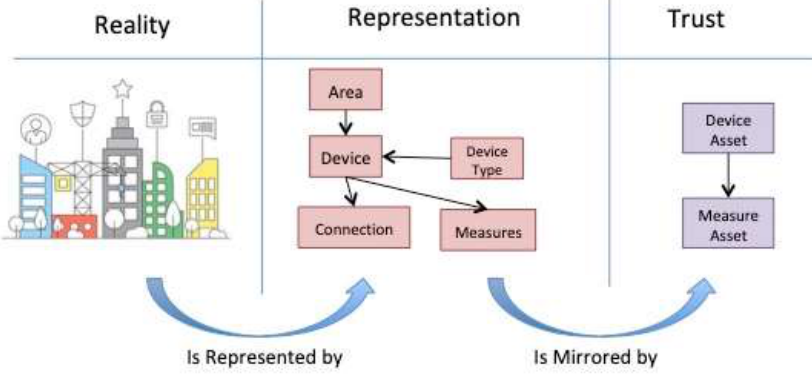
Figure 1. Mirror Model domains.